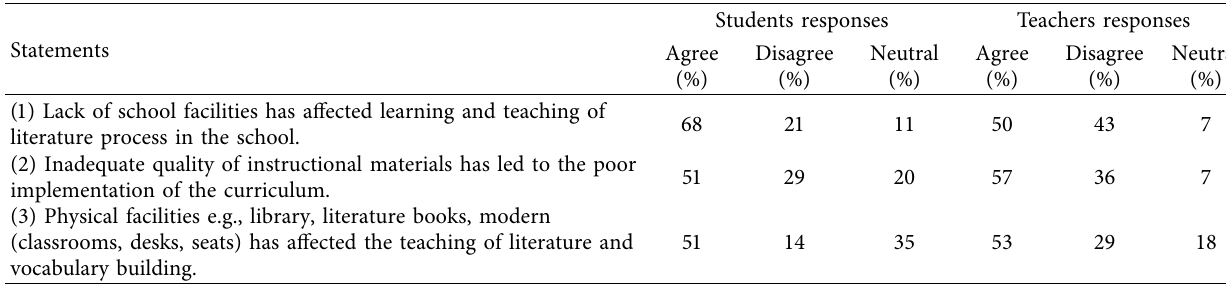
Table 2: Summary of subjects’ responses to school facilities.